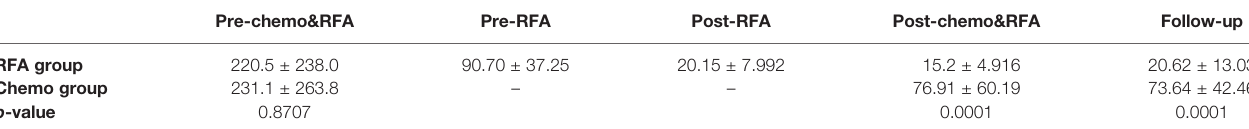
TABLE 3 | serum CA-125 levels (U/mL) for all patients.